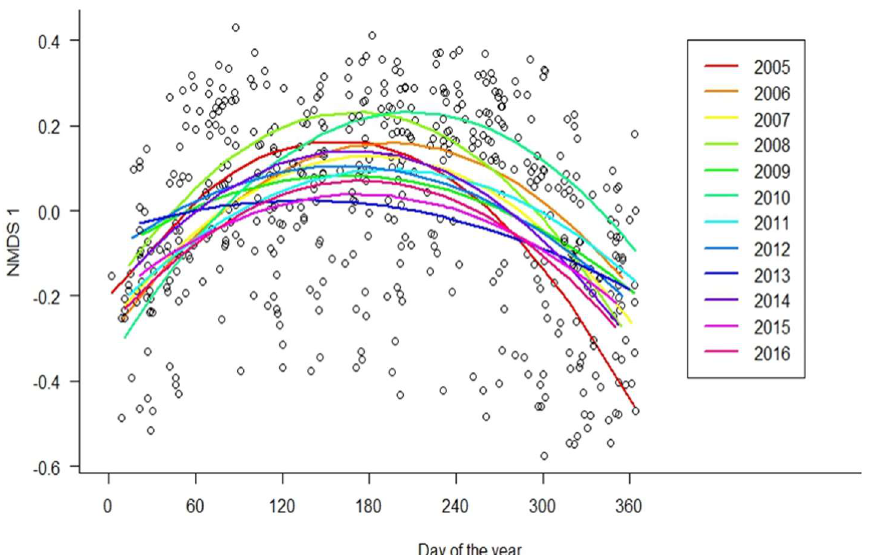
Figure 7. Butterfly community composition (summarized by the first non-metric multidimensional scaling axis) varied over the course of the year, as well as among years. As winter temperatures become more suitable for butterfly activity, the flight season of individual species are spreading out to take advantage of the colder months. As a result, butterfly communities are becoming less seasonal, and broad patterns of community composition are responding less strongly to the day of year as a predictor, as seen here by the flattening of the quadratic regression lines in warmer years, and roughly as the years of sampling progress. Each color represents a different sampling year, and the order follows the colors of the rainbow (i.e., 2005 is red and 2016 is purple). Notice that 2010 was a particularly cold year, and the regression line has a pronounced arch, similar to curves from earlier in the data collection, such as 2005. Conversely, 2012 and 2013 were warmer years, and have relatively little change in community composition over the course of the year. Individual points represent all sampling bouts, unseparated by year.